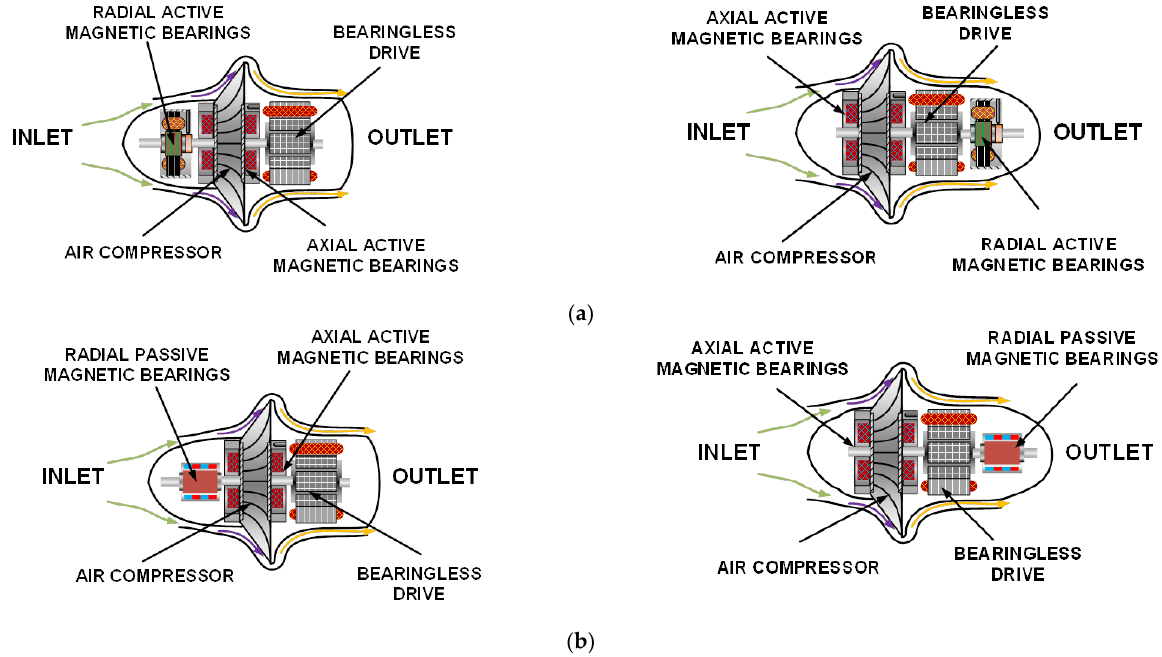
Figure 1. Concepts of the electric jet engine: configurations of jet engines with radial and axial active magnetic bearings and with a bearingless drive ( a ); configurations of a jet engine with one passive radial magnetic bearing, one axial active magnetic bearing and with a bearingless drive ( b ).